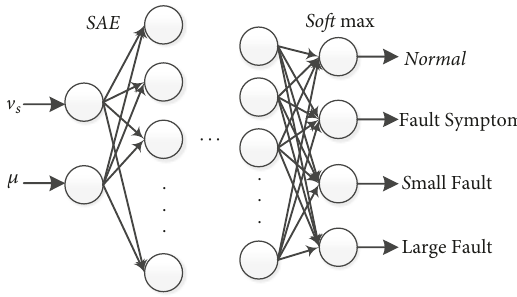
Figure 3: Schematic of the network